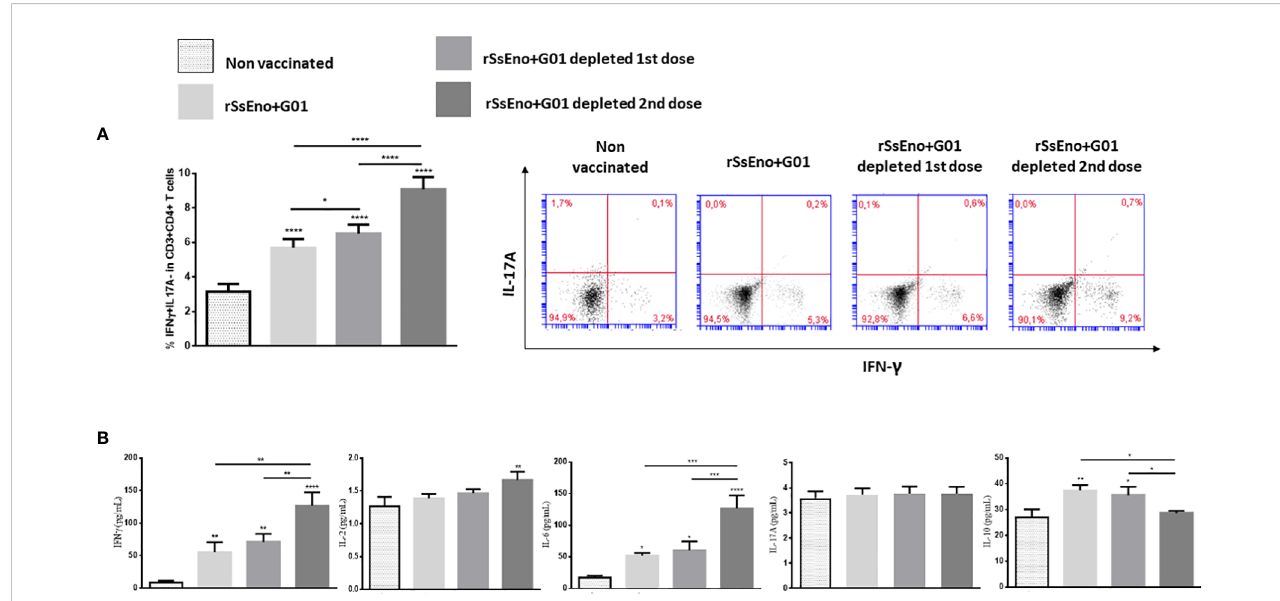
FIGURE 2 Tregs depletion during boost immunization leads to increased stimulation of IFN g +Th1 lymphocytes (A) , and increased production of IFN g , IL-2, and IL-6 associated with reduced IL-10 compared to the group without Tregs depletion (B) . Vaccination did not stimulate IL-17 production. To analyze the effect of Tregs depletion on the Th1/Th17 response, both male WT littermate and DEREG mice received two subcutaneous injections (0.1 ml) on days 0 and 14 with rSsEno + Gel 01, or PBS alone (non-vaccinated control). Immunized mice were treated with 1 m g of diphtheria toxin (DT) intraperitoneally (i.p.) for two consecutive days, before 24 hours, and during either the fi rst (priming) or the second dose (booster). Immunized and control mice were euthanized 21 days after the primary immunization and their splenocytes were stimulated for 24 hours with 10 m g of rSsEno/mL. The supernatant-accumulated cytokines (IL-2, IL-6, IL17A, IFN- g , and IL-10) were measured by Cytometric Bead Array Th1/Th2/Th17 Cytokine Kit. The results are presented as the mean ± SD of 7 mice per group from two independent experiments, and statistical signi fi cance was determined by one-way ANOVA using Tukey ’ s multiple comparisons tests. *(p < 0.05); **(p < 0.01); ***(p < 0.001); ****(p <